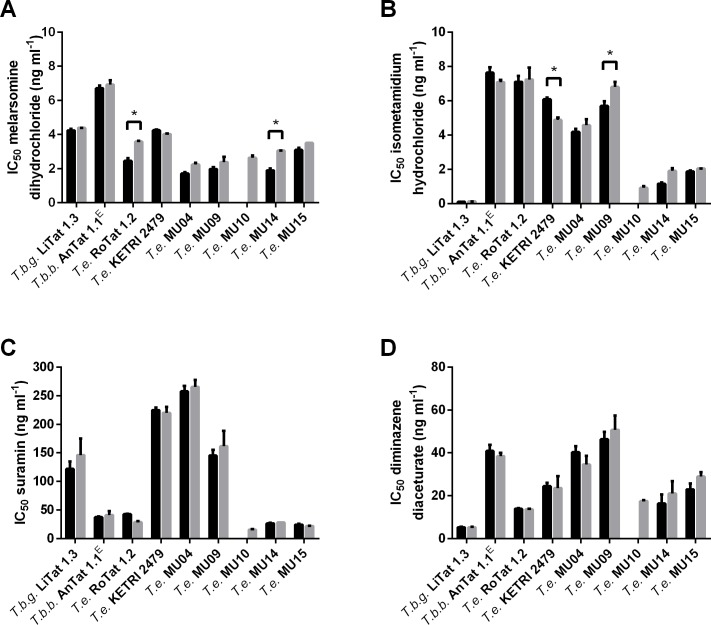
In vitro drug sensitivity of T. evansi.IC50 values for different drugs, with standard deviation error bars, obtained with different Trypanosoma sp. stocks and strains after 30 (black bars) and 60 days (grey bars) in vitro culture. Significant differences between IC50 values of 30 and 60 days in vitro cultures are indicated by an asterisk. T.b.g. = T.b. gambiense, T.b.b. = T.b. brucei, T.e. = T. evansi, MU = MCAM/ET/2013/MU. Panel A: IC50 values for melarsomine dihydrochloride. Panel B: IC50 values for isometamidium hydrochloride. Panel C. IC50 values for suramin and Panel D: IC50 values for diminazene diaceturate.